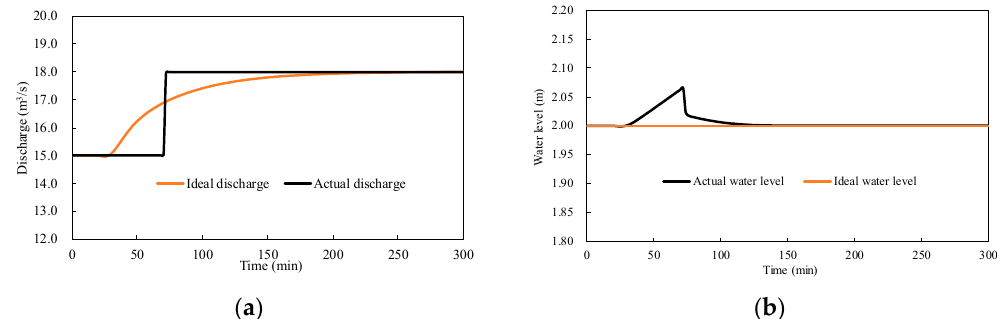
Figure 3. The variation of the discharge of the pumping station ( a ) and water level immediately upstream of the pumping station ( b ).